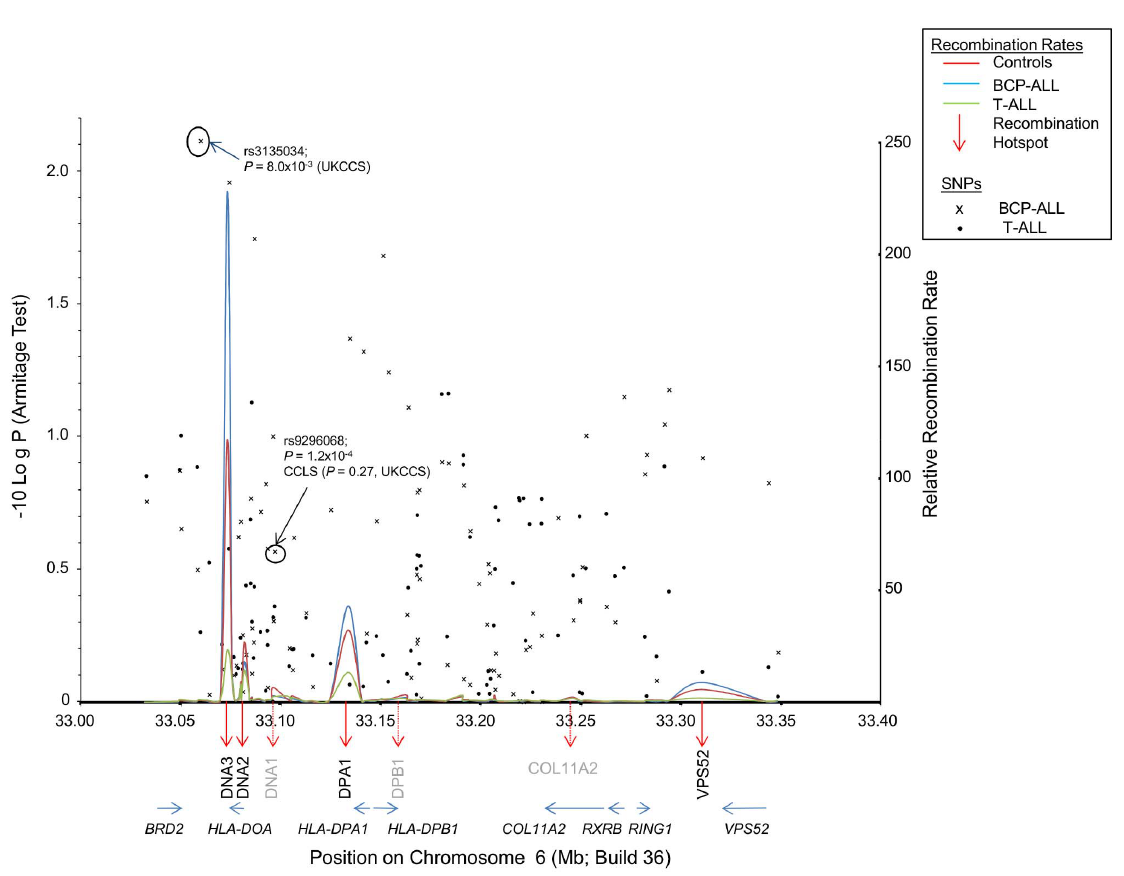
Figure 1. Relative recombination rates (right Y axis) at DNA3 and flanking hotspots in Controls (red line), BCP-ALL cases (blue line), and T-ALL cases (green line), estimated using PHASE plotted over –Log P values (linear regression; left Y axis) for SNP associations. SNPs identified in array-based association studies of childhood ALL, rs3135034 (UKCCS [18]) and rs9296068 (CCLS)[19] are indicated. Recombination at DNA3 is significantly higher in BCP-ALL cases than controls (P=0.02), and significantly lower in T-ALL cases (P=0.048). There is no significant difference at flanking hotspots.